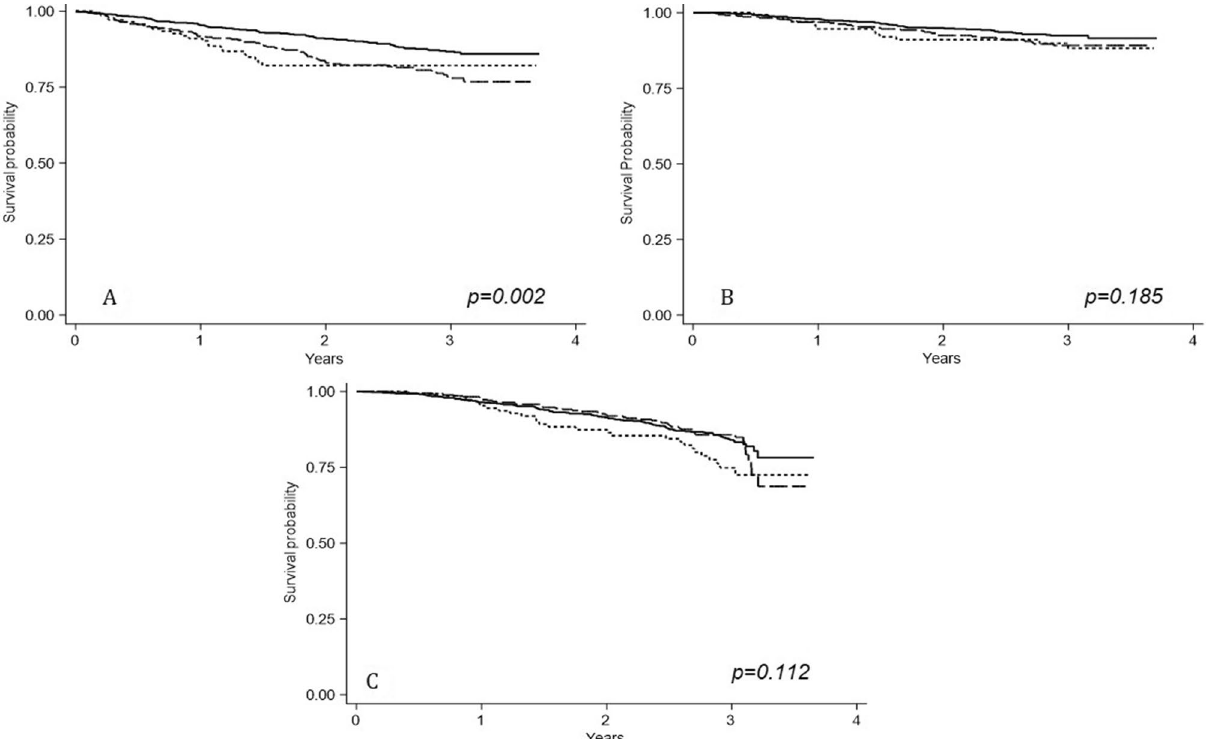
Figure 1. Survival probabilities of CV fatal/non-fatal events ( A ), all-cause death ( B ) and Renal events ( C ) according to smoking habit categories. Continuous line refers to never smokers; long-dashed line refers to former smokers; short-dashed line refers to current